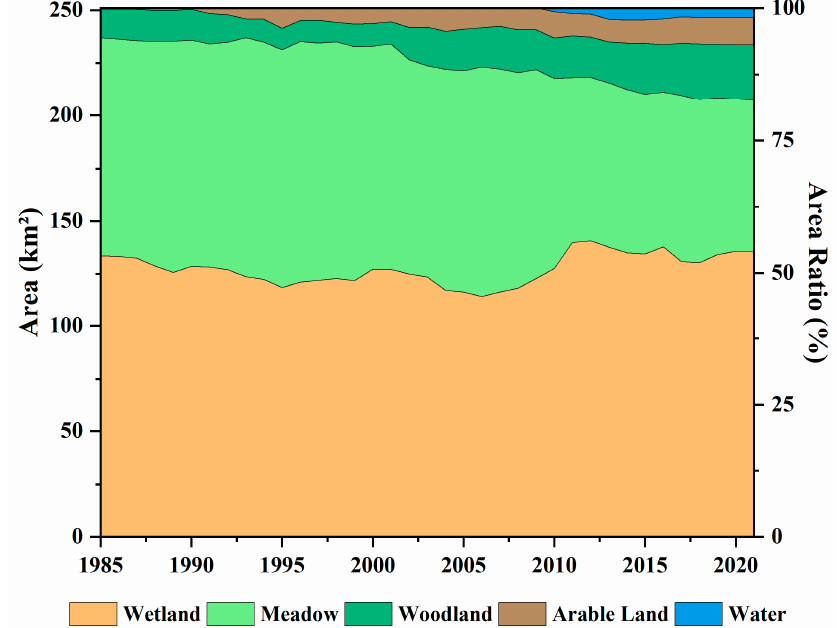
Figure 4. Area change map of various landscape types in the HNNR from 1985 to 2021.